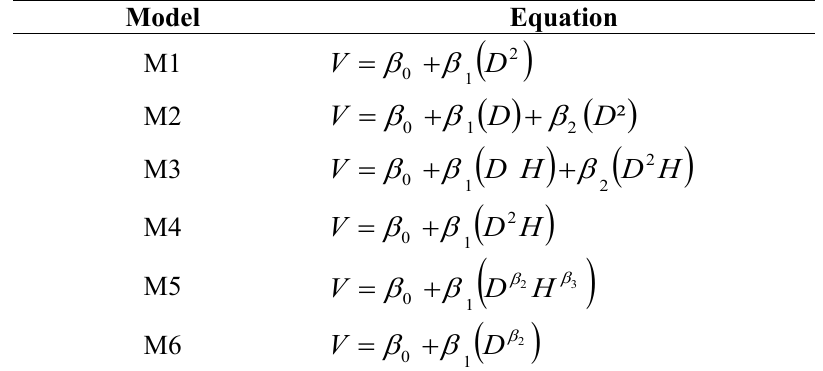
Table 3. Scaling formulas of total volume and merchantable volume of the teak tree.